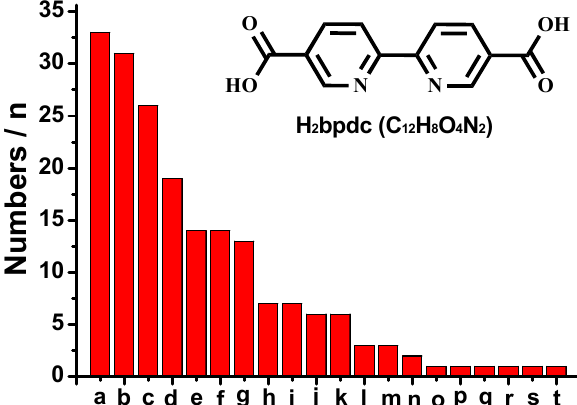
Figure 1. The number of published structures which contain H 2 bpdc ligands in different coordination modes. a–t represent the types of coordination modes, see Scheme S1.